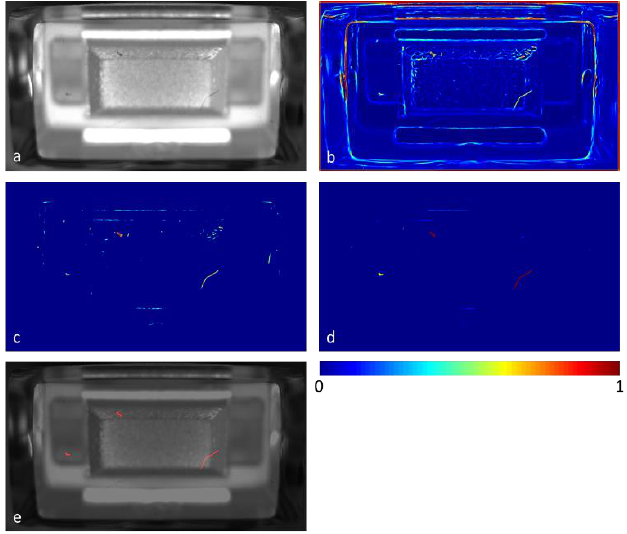
Figure 4. Flowchart of the proposed defect detection algorithm.